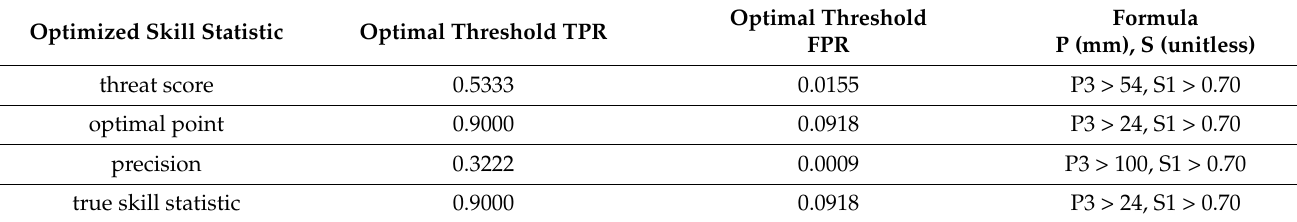
Table 1. Summary of skill statistics calculated for four contrasting thresholds with the same variables and daily timescales of 3 days of cumulative precipitation (P3) and 1-day average antecedent saturation (S1) as shown in Figure 2.